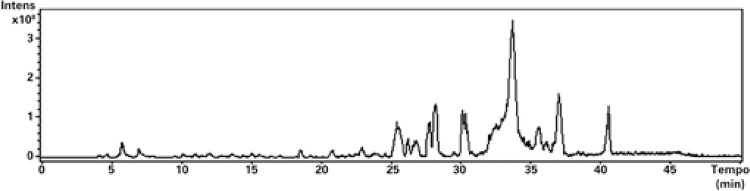
Cromatograma de corrente de íon total obtido de ionização por eletrospray